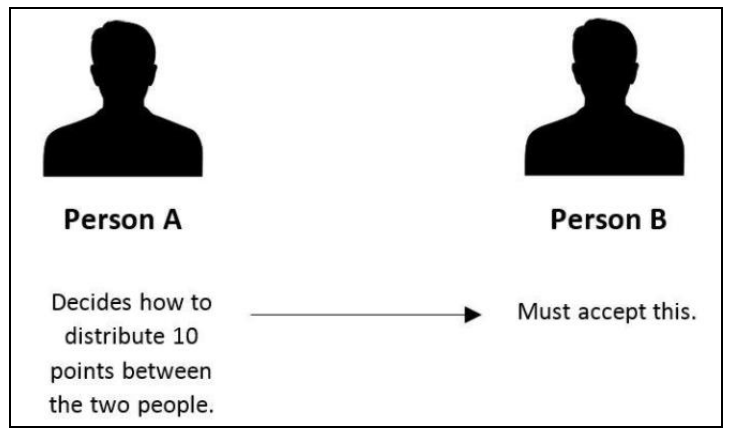
Figure A1. Screenshot of visualization presented to participants in the standard dictator game.